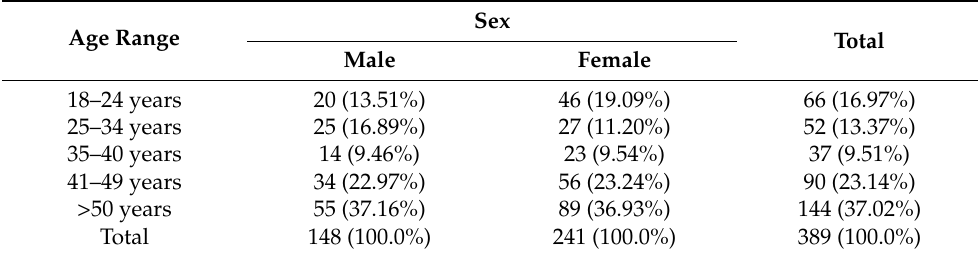
Table 2. Age range and gender in the adult